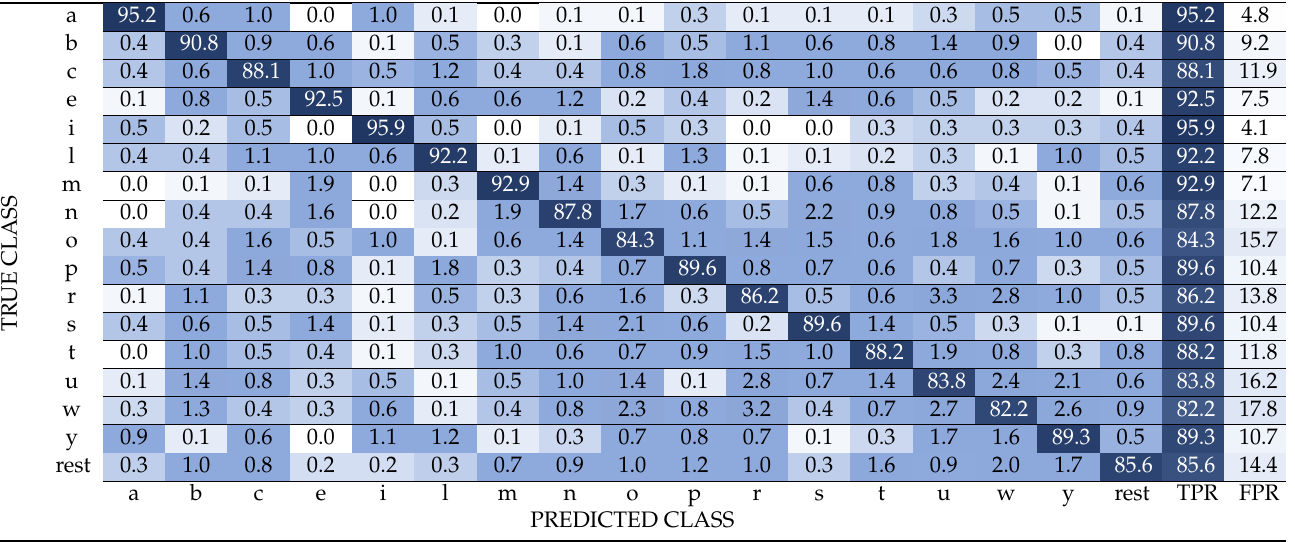
Table 2. Confusion matrix for k -NNiRS method, while k = 1, obtained with feature vector limited to three sensors (expressed as a